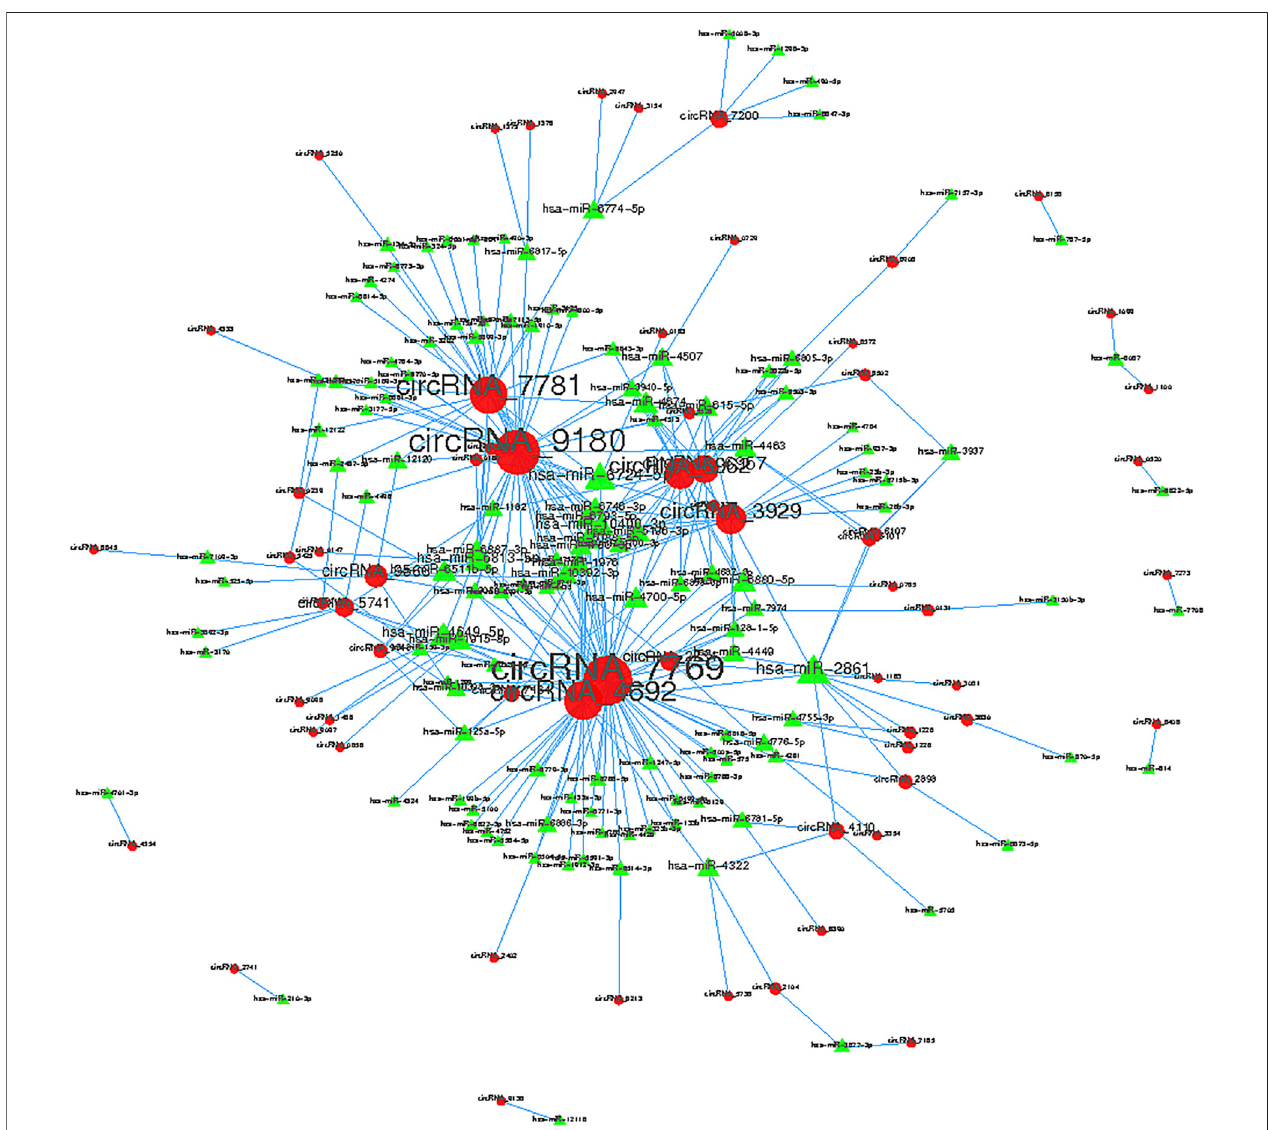
FIGURE 6 | Top 300 predicted circular RNA-miRNA relationships. In the network, red nodes represent circRNAs, green inverted triangles represent the predicted miRNAs. and the edges represent sequence matching.